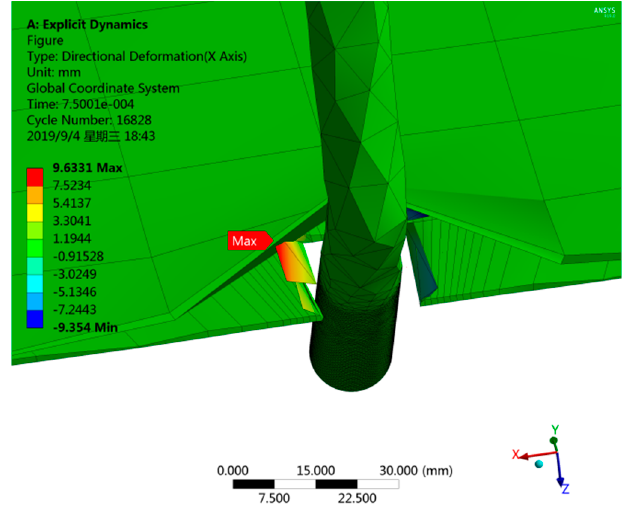
Processes 2022 , 10 , x FOR PEER REVIEW Figure 9. The total deformation of the film-picking mechanism. Figure 9. The total deformation of the film-picking mechanism.